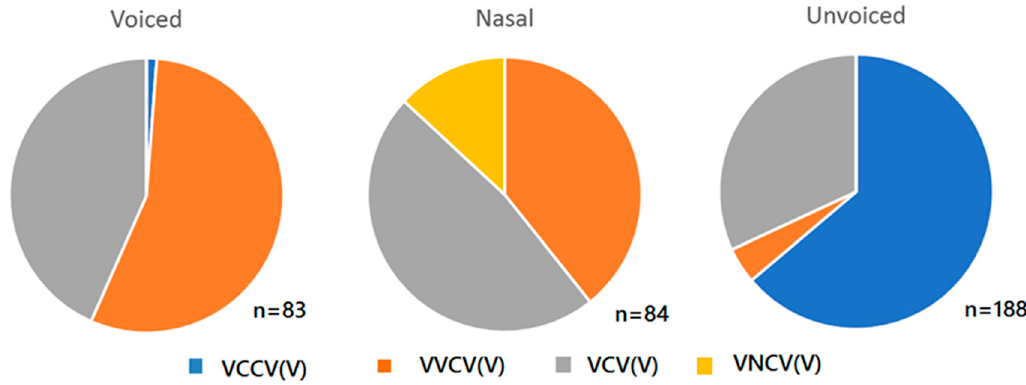
Figure 5. Phonological patterns of adjectives in Niigata: Toyama data.